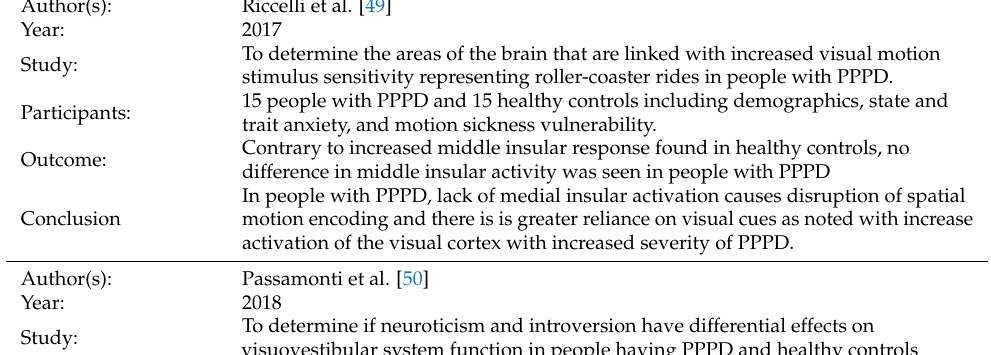
Table 2. Current trends of virtual-reality engagement for